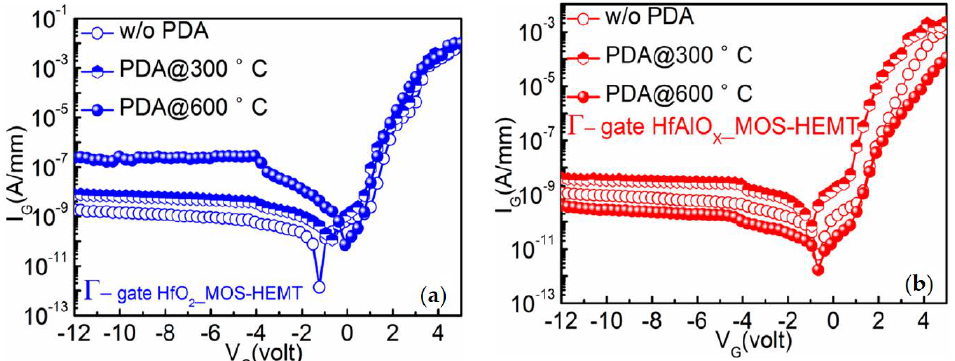
Figure 2. Comparison of gate leakage characteristics of ( a ) Γ -gate HfO 2 MOS-HEMT and ( b ) Γ -gate HfAlO X MOS-HEMT with the PDA at 300 and 600 ◦ C and without the